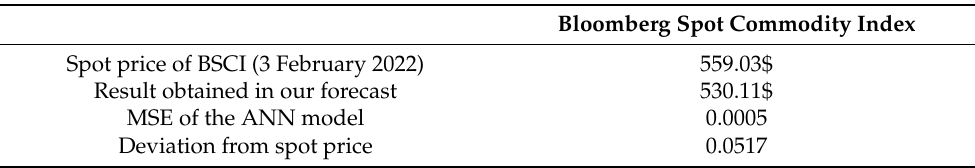
Table 4. Forecast results and accuracies of the time series of commodity prices, after a structural break, using the ANN